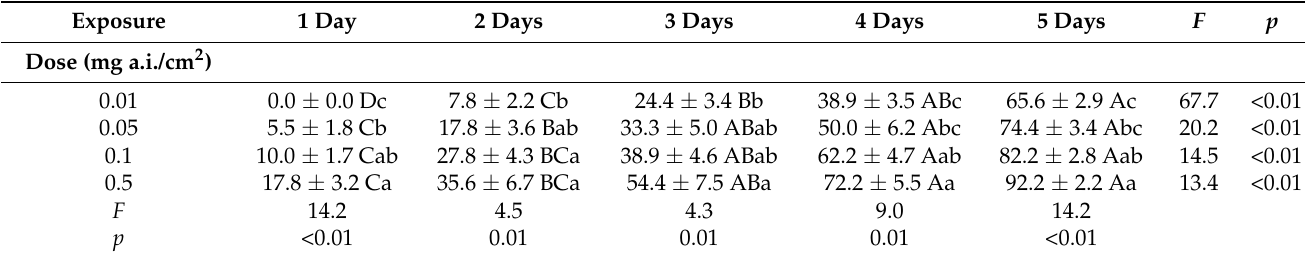
Table 6. Mean immediate mortality (% ± SE) of Acarus siro adults exposed on concrete treated with chlorantraniliprole at four doses (0.01, 0.05, 0.1, and 0.5 mg a.i./cm 2 ), for 1, 2, 3, 4, and 5 days. Within each row, means followed by the same uppercase letter are not significantly different (in all cases DF = 4, 44, Tukey–Kramer HSD test at p = 0.05). Within each column, means that are followed by the same lower-case letter are not significantly different (in all cases DF = 3, 35, Tukey–Kramer HSD test at p = 0.05). Where no letters exist, no significant differences were recorded.